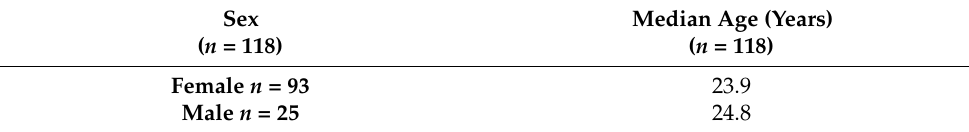
Table 5. Demographic structure of the respondents in the evaluation